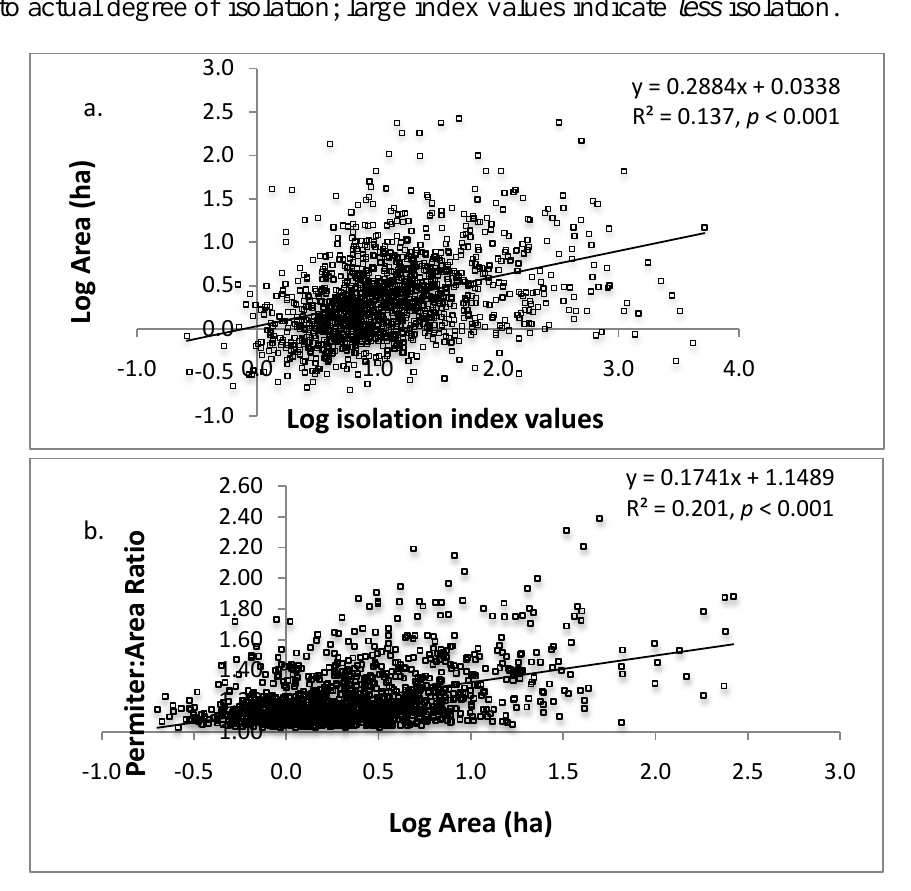
Figure 4. Linear regressions of a) log isolation against log area (ha) of sacred grove; and b) log area (ha) against the perimeter:area ratio. The shape index measure the deviation from a circle (deviation = [perimeter / 2 * sqrt (area * π)]. Isolation index values are inversely related to actual degree of isolation; large index values indicate less